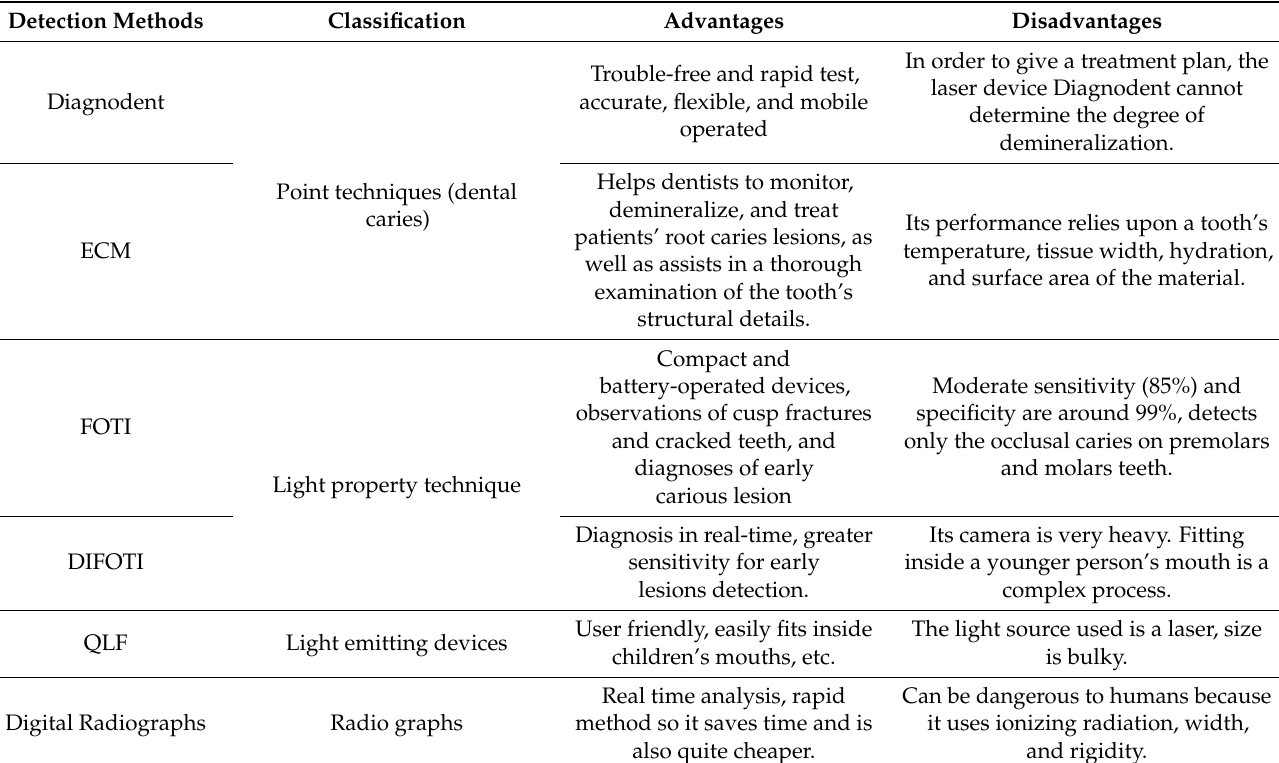
Table 1. Advantages and disadvantages of some detection methods for human teeth disease